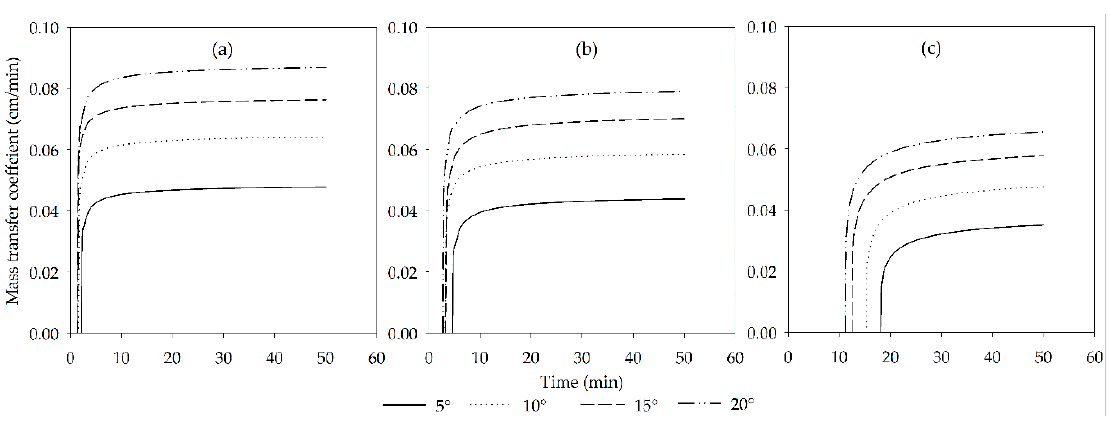
Figure 6. The mass transfer coefficient changes over time under different slope gradients and different rainfall intensities: ( a ) 75 mm/h, ( b ) 50 mm/h, ( c ) 25 mm/h.